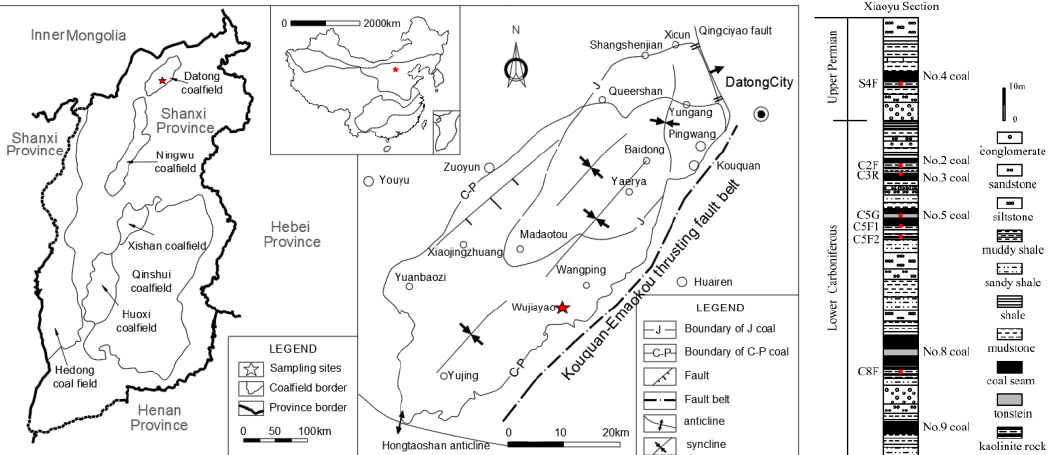
Figure 1. The geographical location of the Datong coalfield and column chart of kaolinite rocks in Xiaoyu mine.